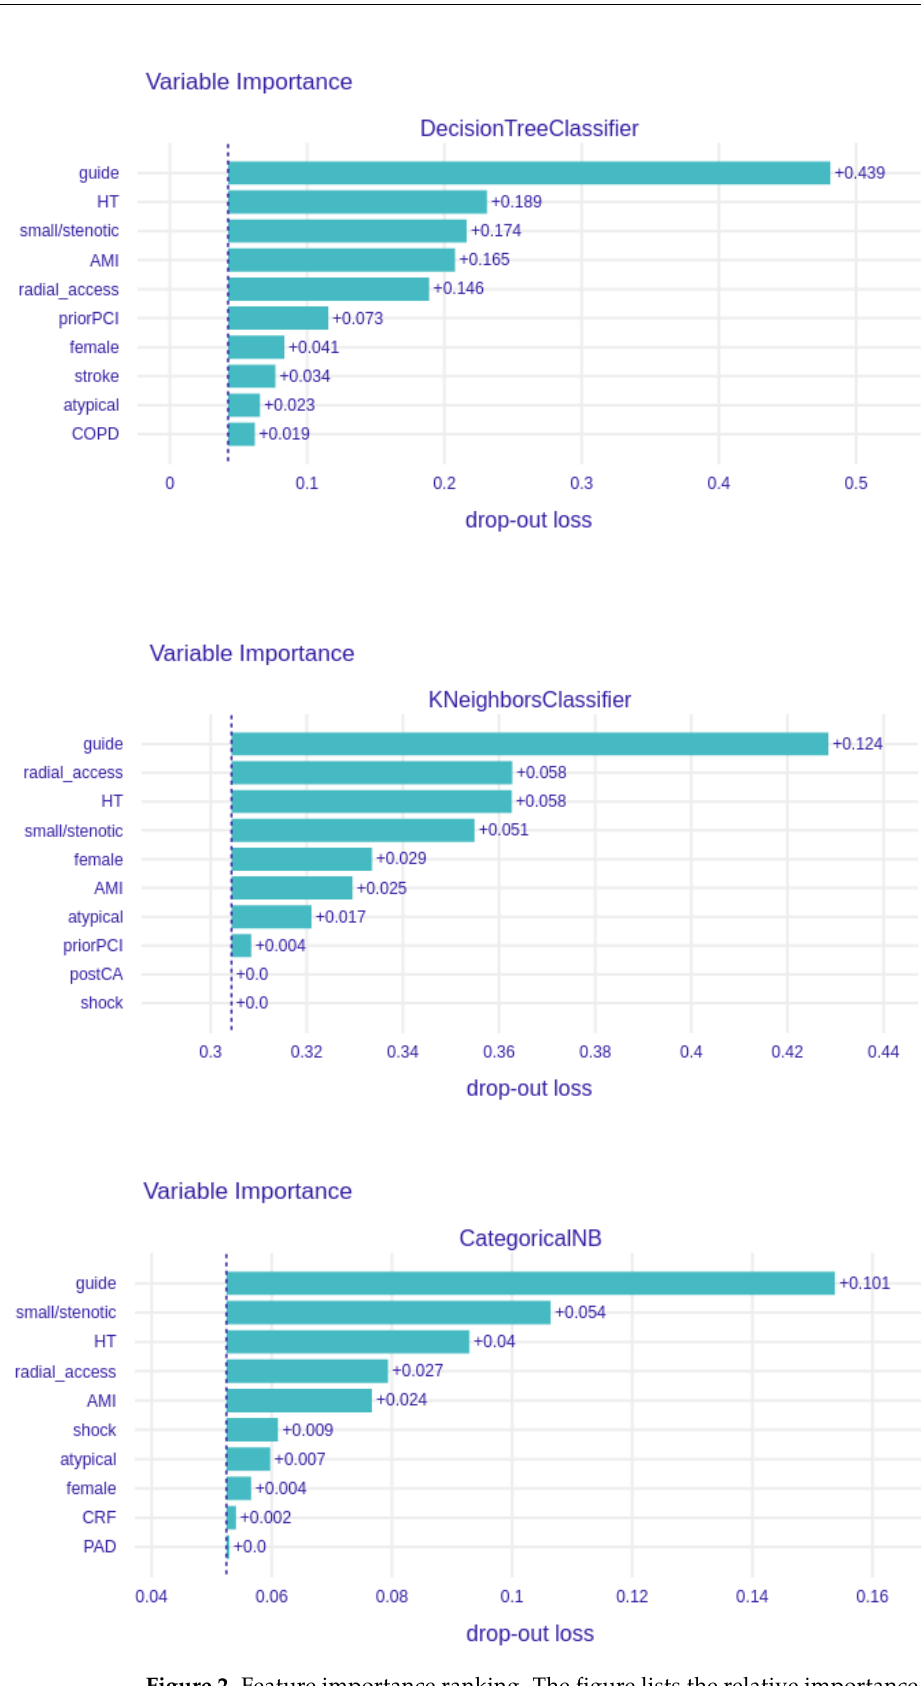
Figure 2. Feature importance ranking. The figure lists the relative importance of variables in all six models used for the prediction of catheter-induced dissections. AMI: acute myocardial